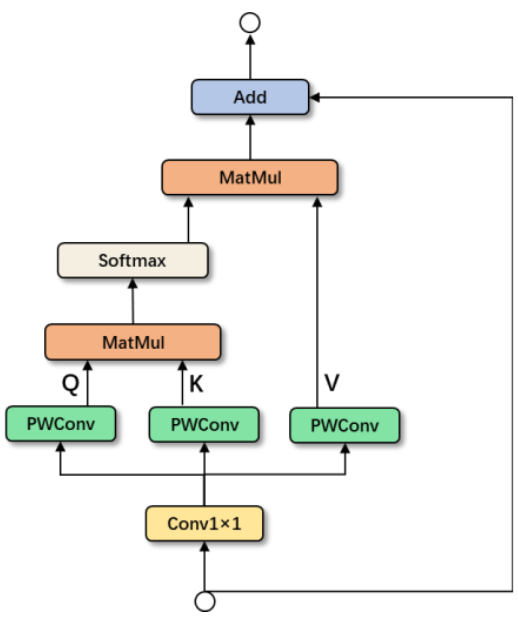
Figure 6. Structural diagram of multi-head self-attention.